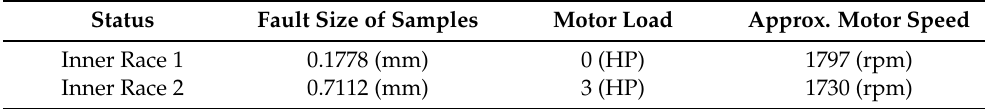
Table 2. Structural parameters of rolling